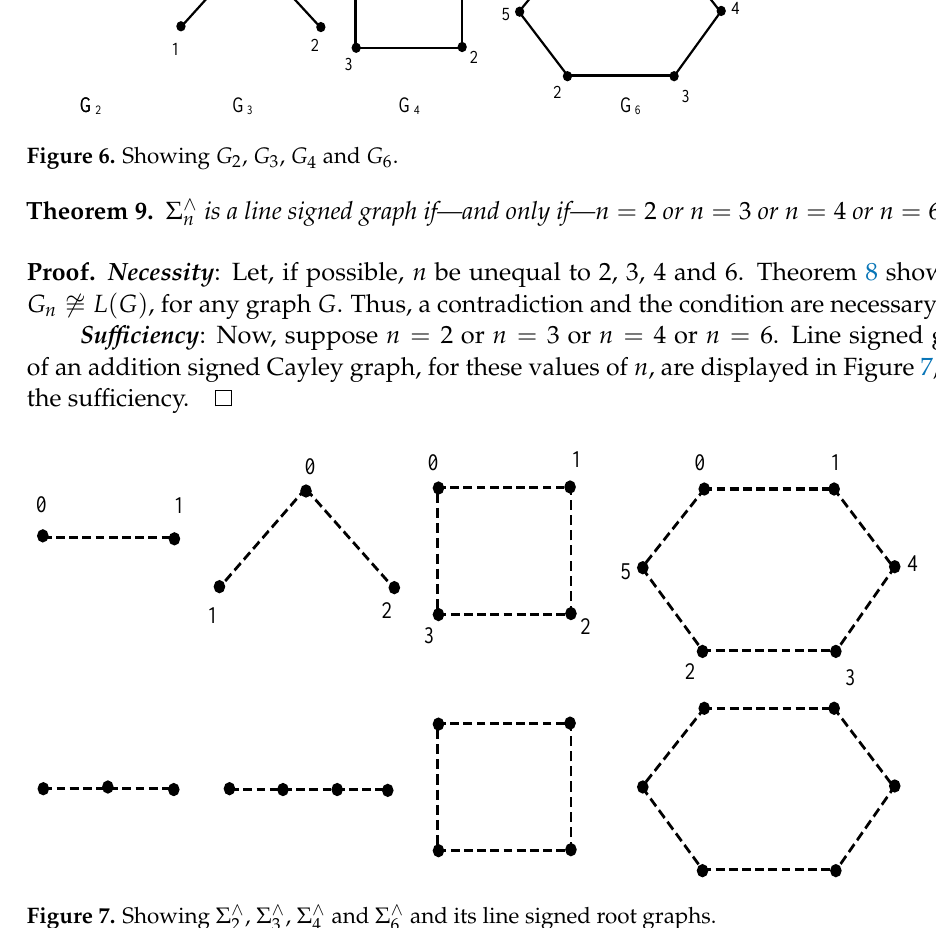
, Σ ∧ , Σ ∧ and Σ ∧ and its line signed root 2 3 6 4